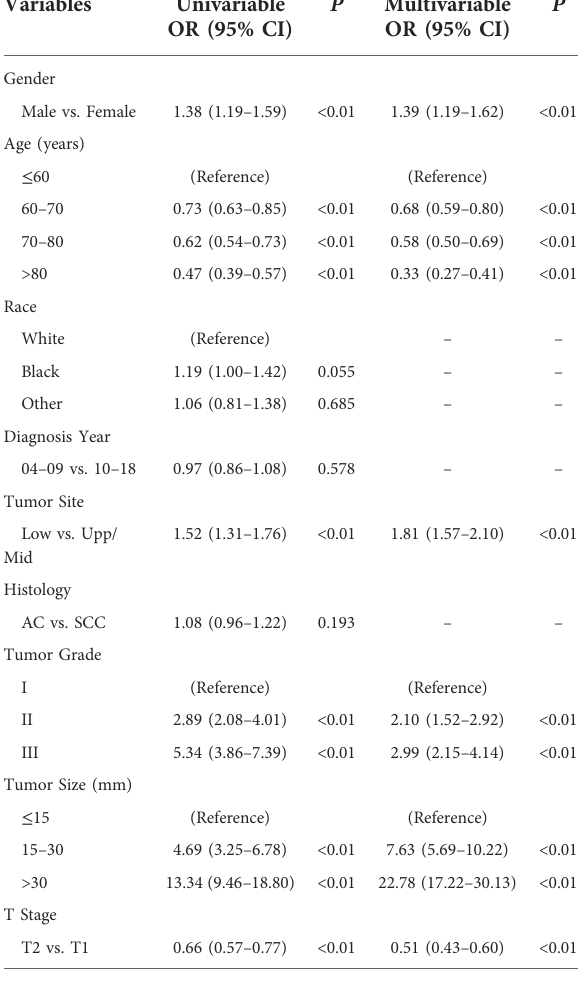
TABLE 2 Univariable and multivariable analyses of variables associated with distant metastases.